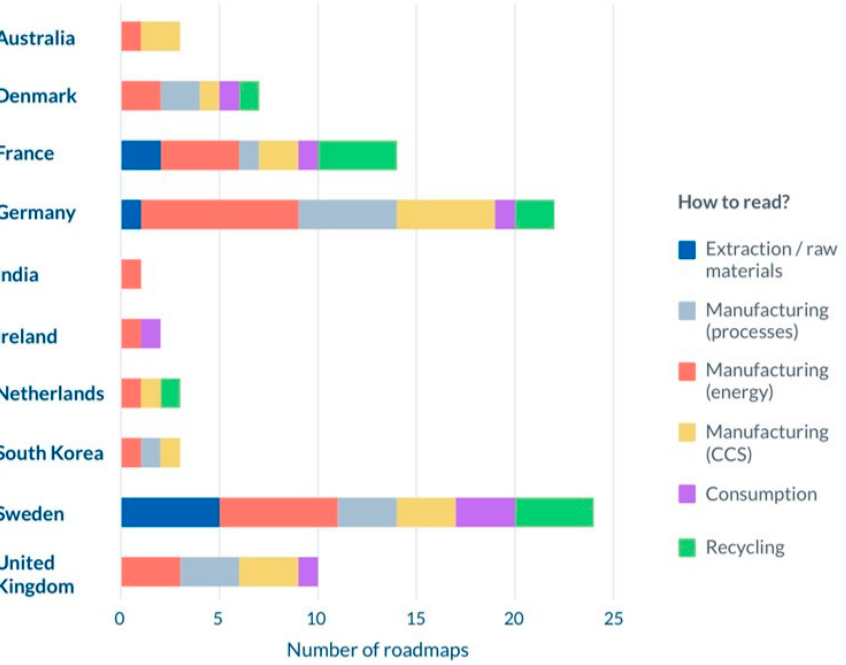
Figure 2. Types of proposed mitigation measures, by country (source: author’s own).